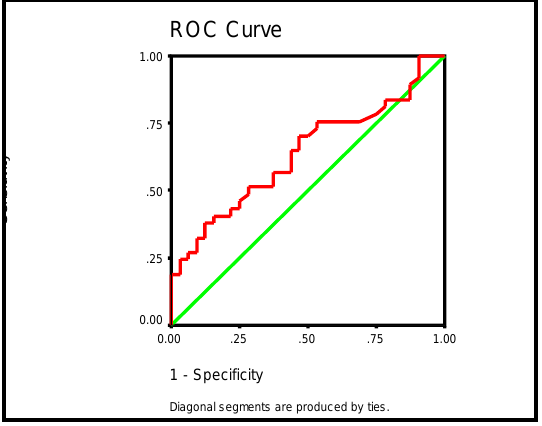
Fig. 1. ROC Curve plot for studied COVID -19 deaths/M on 2/September 2020) marker in relation to periods of elimination of malaria